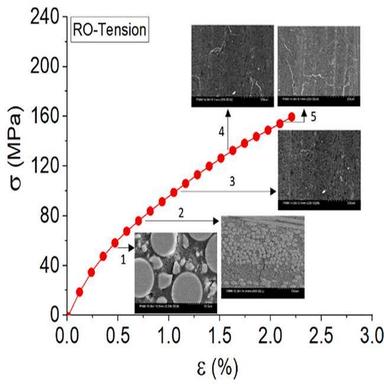
Quasi-static tensile tests for RO-A-SMC composite coupled to the microstructure observation; (1): fiber/matrix debonding, (2): fiber/matrix debonding propagation and matrix micro-cracking, (3), (4) and (5): matrix micro-cracking and pseudo-delamination mechanisms.